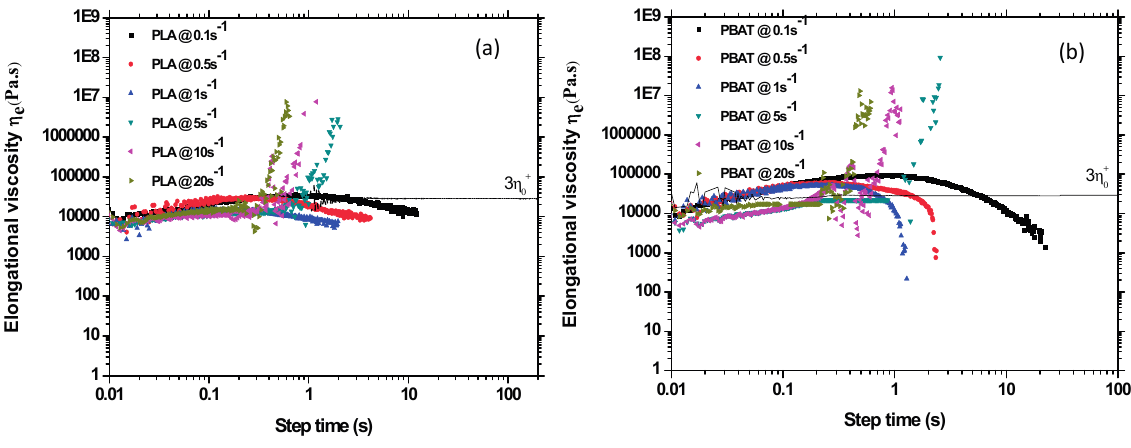
Figure 9. Start-up elongation viscosity versus step time at 180°C for the neat ( a ) PLA polymers and ( b ) PBAT polymers at different elongation